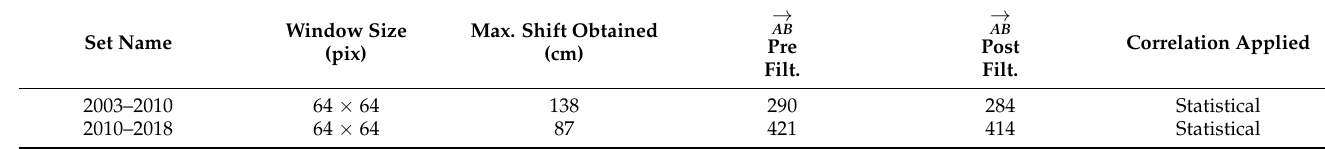
Table 4. Basic data for two selected pairs of orthophotos obtained based on the correlation of historical photographs and imagery from 2003 and 2010 and 2010 and 2018; (